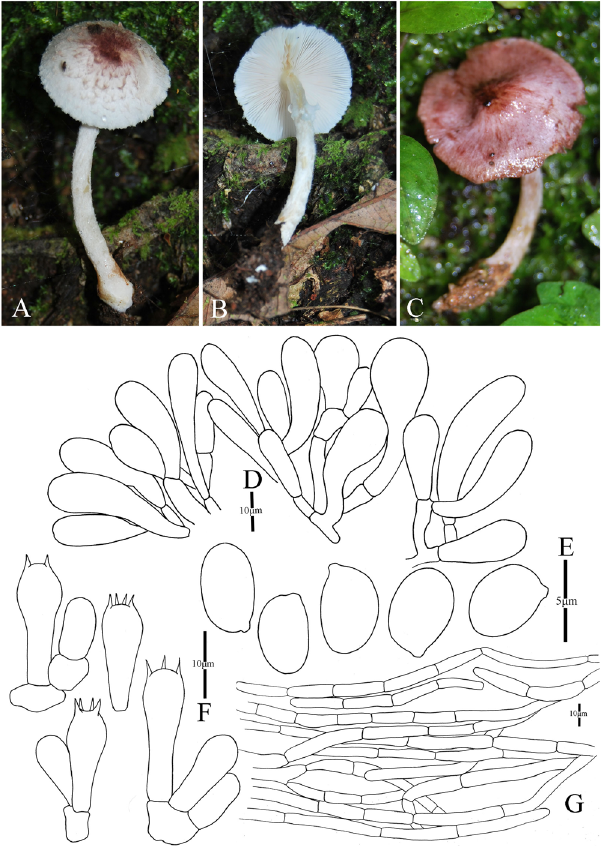
Figure 8. Morphology of Agaricus minorpurpureus ( ZRL2010058 , holotype), ( A – C ): Basidiome in field ( A , B ; ZRL2010058 ; ( C ): ZRL2013342 ), ( D ): Cheilocystidia, ( E ): Basidiospores, ( F ): Basidia, and ( G ): Pileipellis